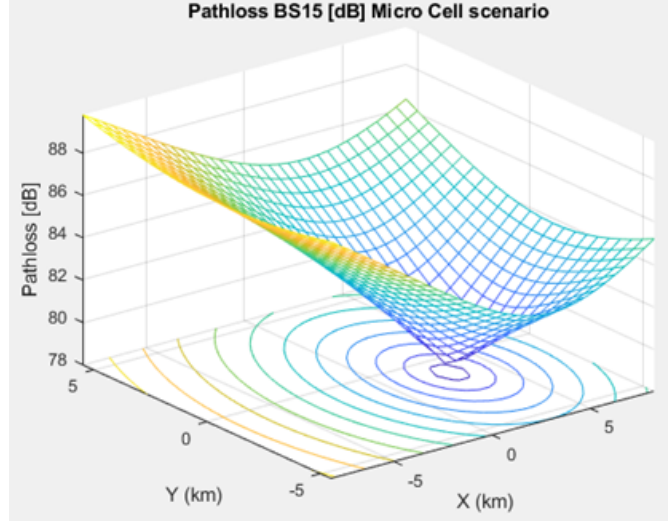
Figure 4. Frame structure of ( a ) NB-IoT downlink OFOMA and ( b ) NB-IoT uplink SC-FDMA.